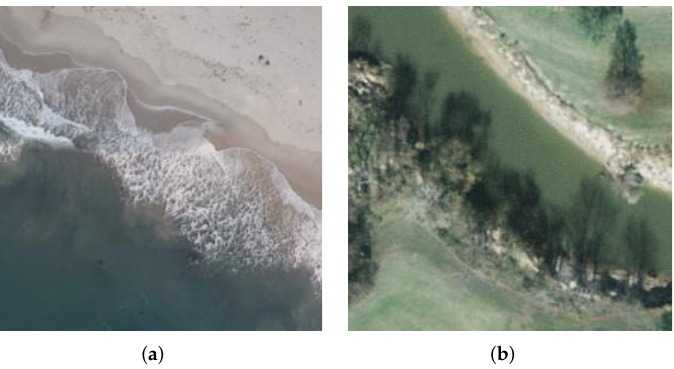
Figure 2. The “direction” among labels in UC-Merced [16,17] archive. ( a ) “Sea” → “Water”. ( b ) “Wa- ter” → “River", not